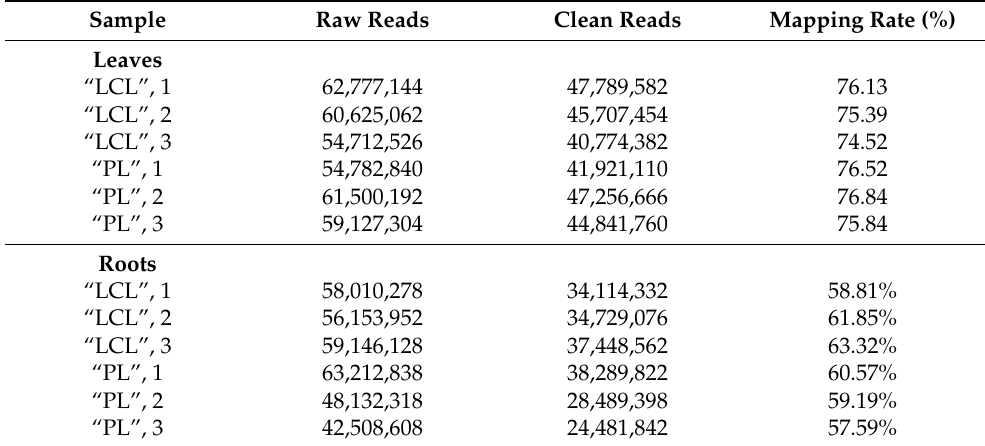
Table 1. Statistics of annotation results for unigenes of two purslanes ( Portulaca oleracea ) genotypes.